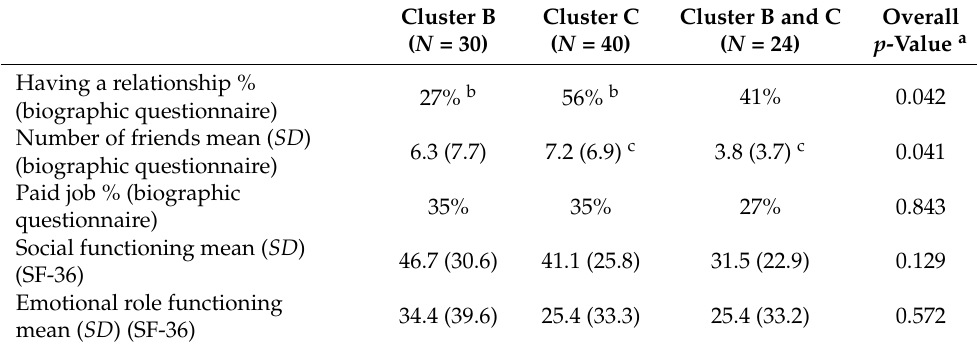
Table 4. Comparison of global functioning variables for cluster B, cluster C and cluster B and C PDs ( N =